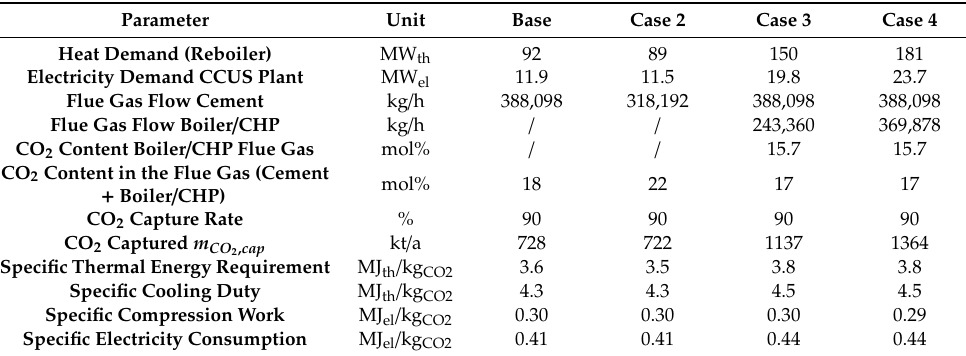
Table 5. Analysis of carbon capture for cement